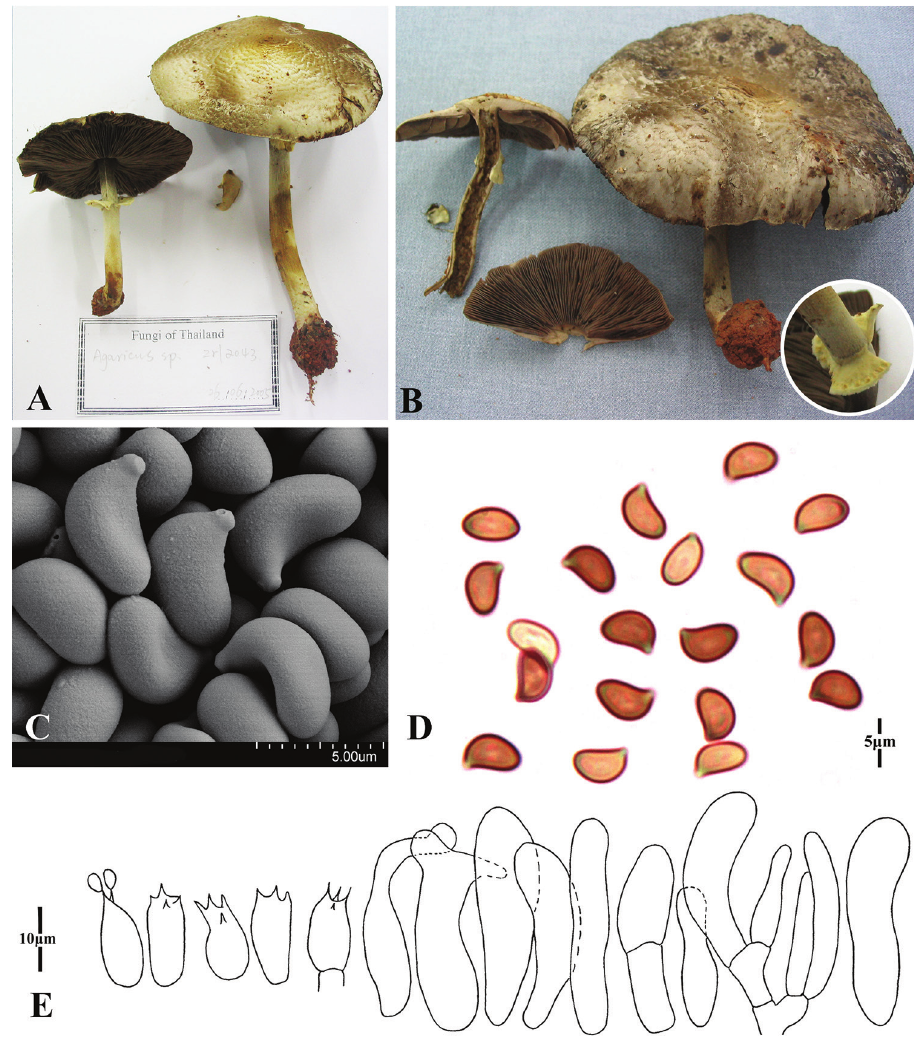
Figure 3. Morphology of Agaricus angusticystidiatus A, B basidiomes C, D basidiospores E basidia and